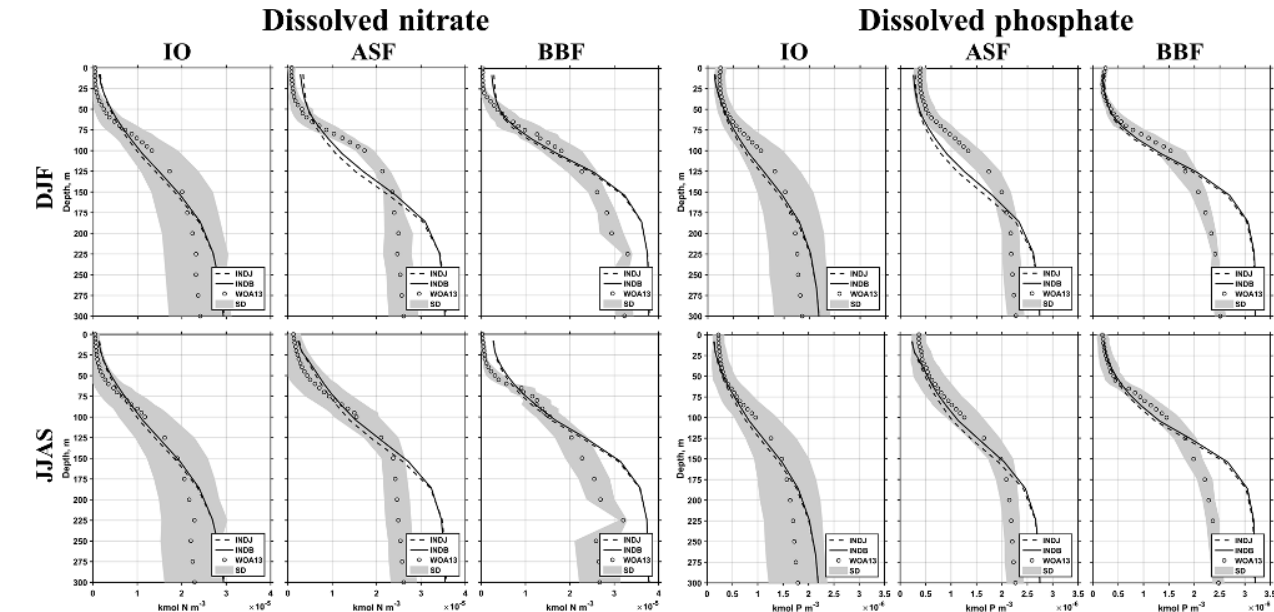
Figure 7. Vertical profiles of dissolved nitrate and phosphate time-averaged seasonally (DJF, JJAS) for the period 1975–2004. INDJ and INDB designate the model runs. WOA13 designates the climatic data from the World Ocean Atlas 2013 (Garcia et al., 2014). SD designates the standard deviation of the WOA13 data.